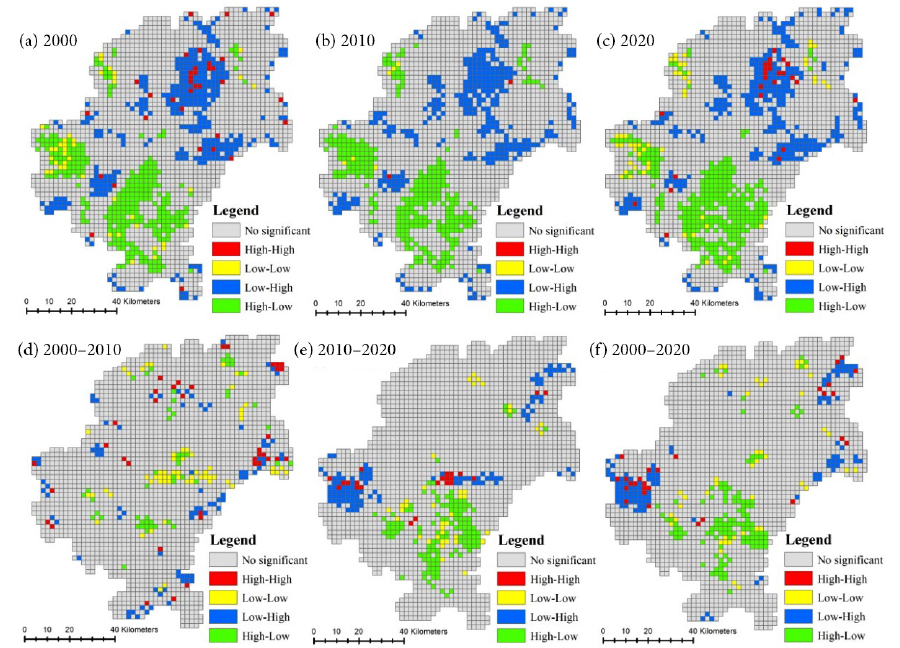
Figure 10. Spatial pattern of the LISA cluster map between the habitat quality and the human activity intensity in